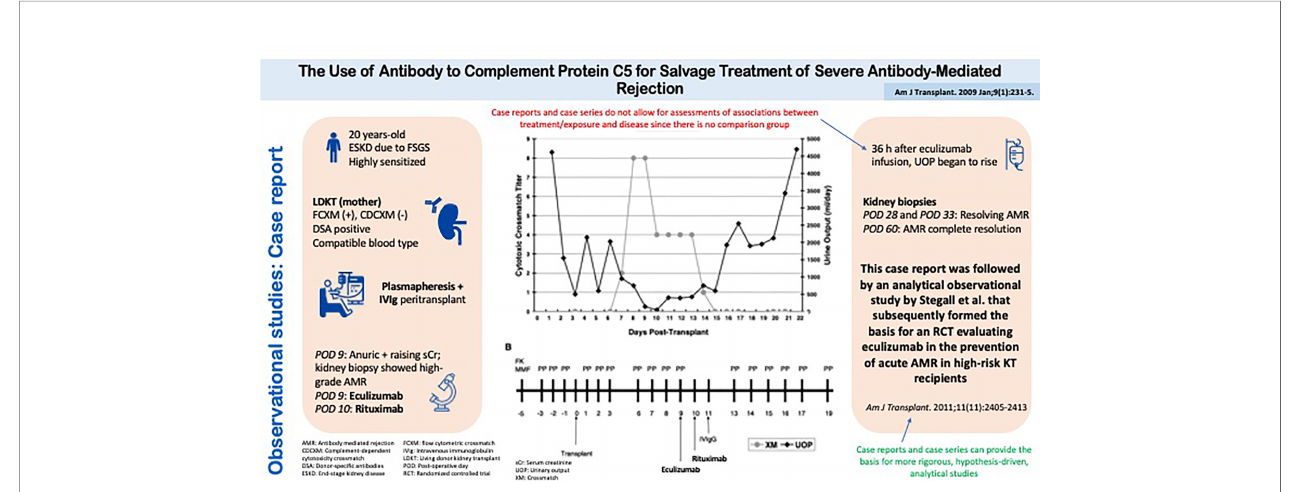
FIGURE 4 | Observational studies: Case Report. The Use of Antibody to Complement Protein C5 for Salvage Treatment of Severe Antibody-Mediated